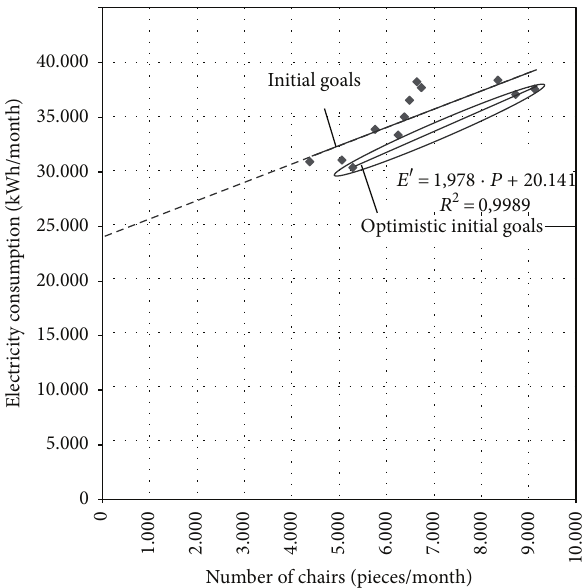
Figure 6: Identifying base (target)